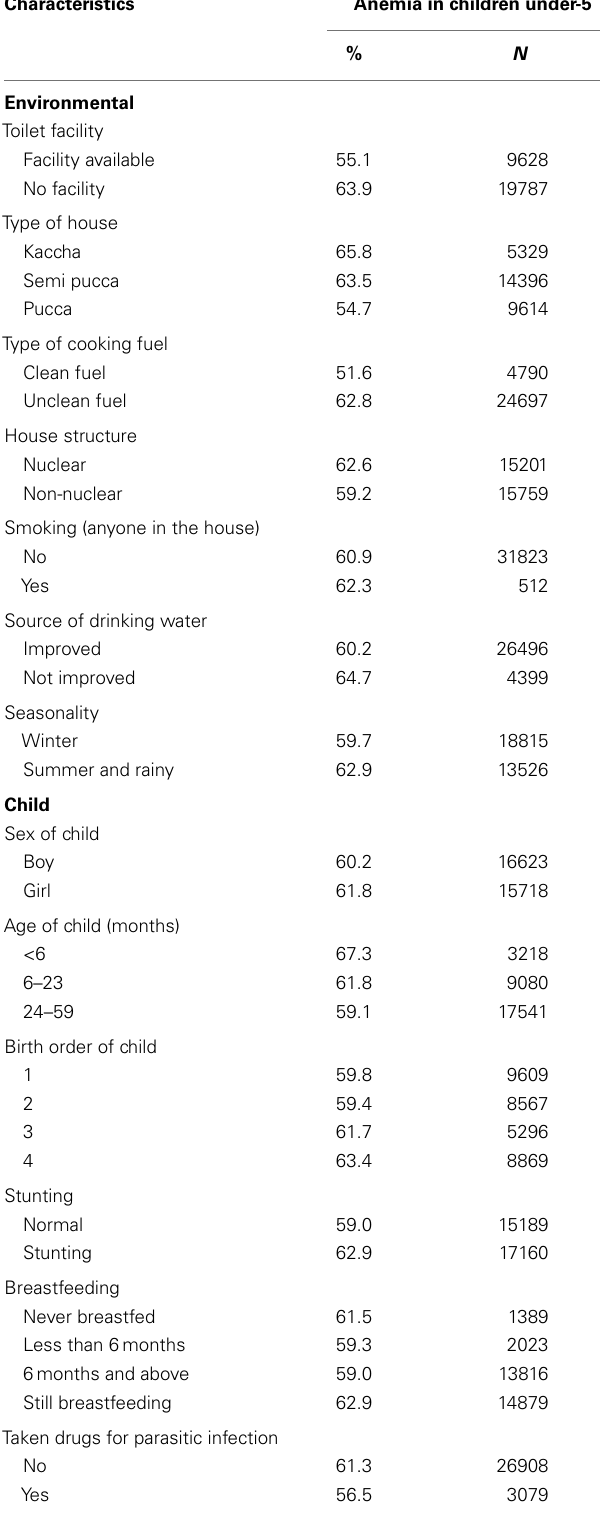
Table 1 | Prevalence of anemia by selected characteristics among children under 5years